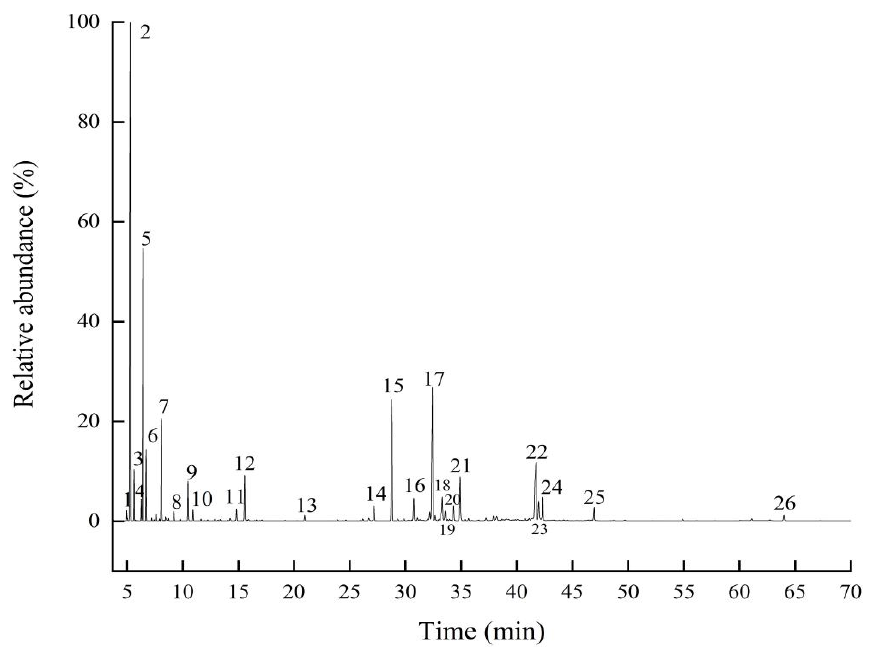
Figure 2. Chromatographic profile of the volatile oil from live branches of P. yunnanensis. 1, α -tricyclene; 2, α -pinene; 3, camphene; 4, sabinene; 5, β -pinene; 6, β -myrcene; 7, limonene; 8, γ -terpinene; 9, terpinolene; 10, β -elemene; 11, β -caryophyllene; 12, humulene; 13, germacrene D; 14, germacrene B; 15, α -muurolene; 16, γ .-muurolene; 17, δ -cadinene; 18, linalool; 19, terpinen-4-ol; 20, α -terpineol; 21, isobornyl acetate; 22, τ -cadinol; 23, α -cadinol; 24, farnesol; 25, sclareol; 26, 1-naphthalenol, 1,2,3,4,4a,7,8,8a-octahydro-1,6-dimethyl-4-(1-methylethyl)-, [1R-(1. α .,4. β .,4a. β .,8a. β .)]-.